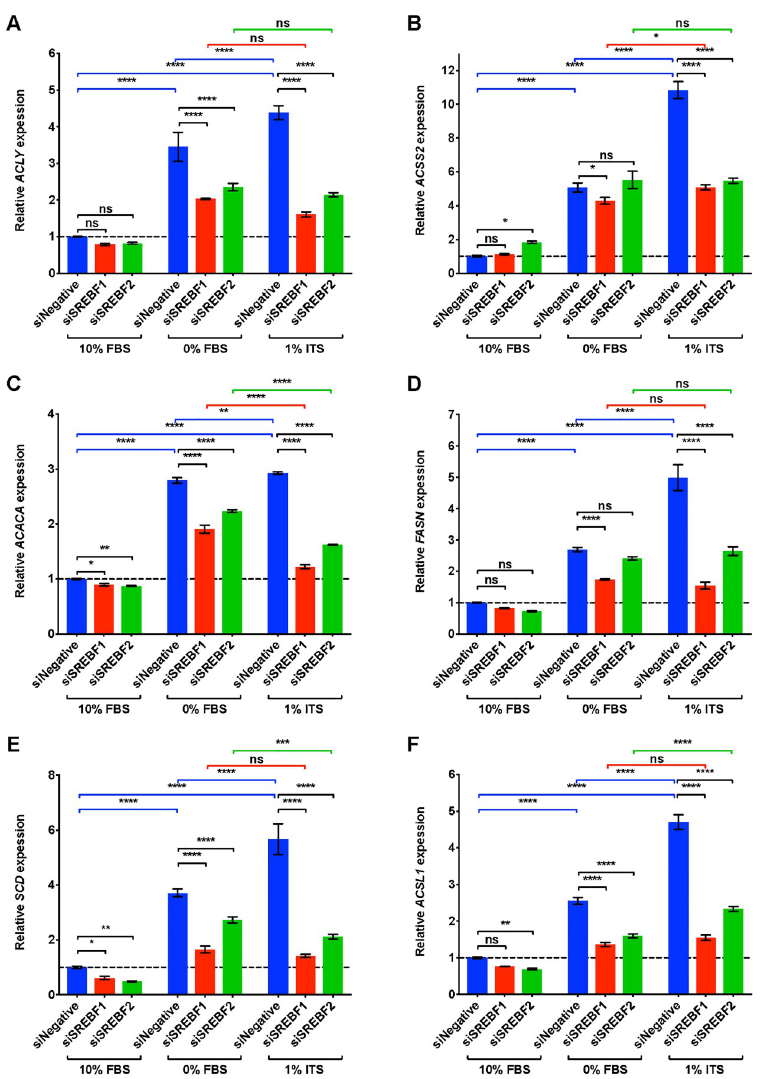
Fig 3. DNFA gene expression of HT-144 cells increases in ITS medium, and this increase is dependent upon SREBP1. (A-F) HT-144 cells were transfected over one day with siRNAs at 50 nM concentrations for non-target control, SREBF1 or SREBF2 . Transfected cells were cultured in 10%, 0% FBS or 1% ITS for two more days before RT- qPCR analyses. RT-qPCR results are presented as expression of DNFA genes relative to their expression under scramble siRNA treatment (siNegative) in 10% FBS medium (set as 1 and marked with a dashed line). When a significant interaction between siRNA treatment and medium condition was detected by two-way ANOVA, individual gene expression was compared within groups by post hoc Tukey’s multiple comparison tests. Each data point represents the mean ± SD of triplicate samples. � , P < 0.05; �� , P < 0.01; ��� , P < 0.001; ���� , P < 0.0001.